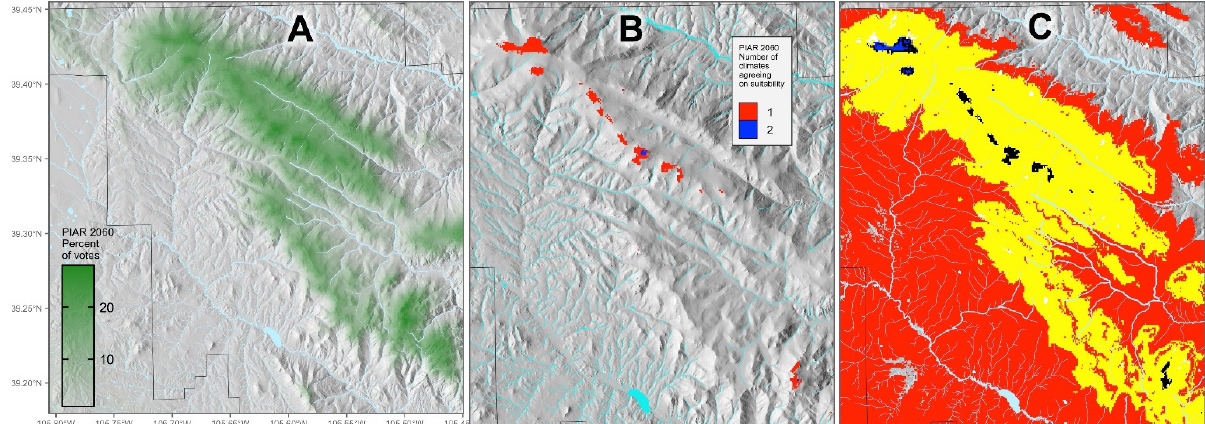
Figure 7. Projections for Pinus aristata in the area with its most favorable future habitat. ( A ) Mean votes of the model based on 11 climates, dark green showing the greatest suitability. ( B ) Areas where 1 or 2 future climates indicate that P. aristata will be suited (votes ≥ 50%). At most only two climates agree in a small area (12 ha). ( C ) Change zones (colors as in Figure 6) based on only the single most favorable climate scenario, CNRMCM5, RCP4.5. This shows that most of the projected suitable habitat in B would be persistent, while a small portion would be emergent.